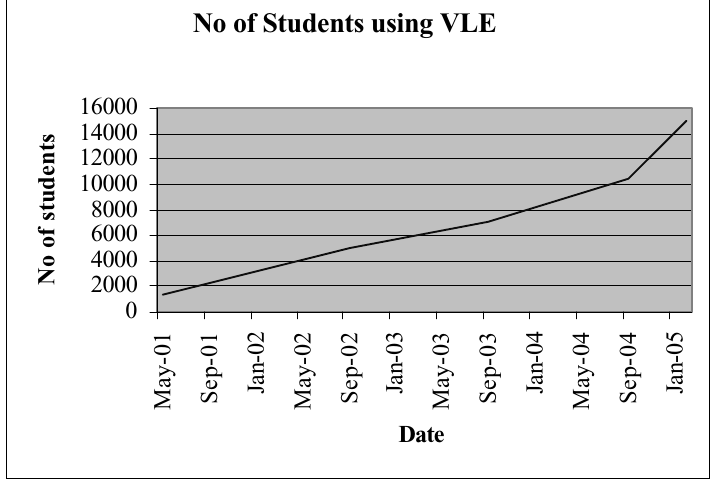
Figure 3. Number of students using the institutional VLE